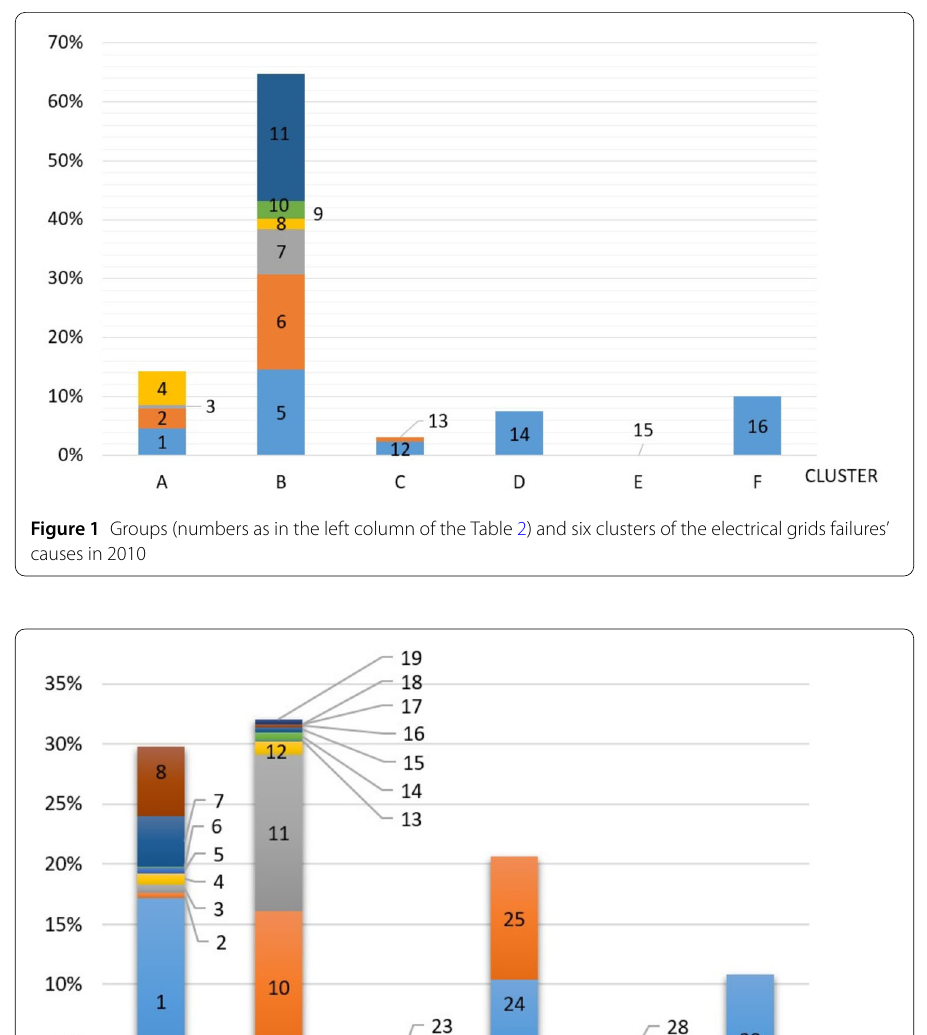
ment (the Large Angle and Spectrometric Coronagraph) on board of SOHO mission (the Solar and Heliospheric Observatory). LASCO functions with three telescopes: C1, C2, and C3. Nevertheless, C1 was put out of action in June 1998. Hence, only C2 and C3 data are used for uniformity